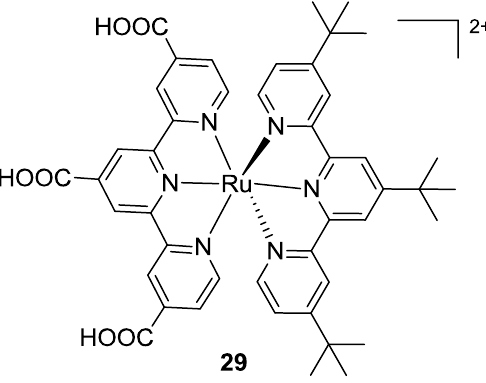
Figure 23. Modification of the BD structure with tris ( t -butyl) tpy [100].